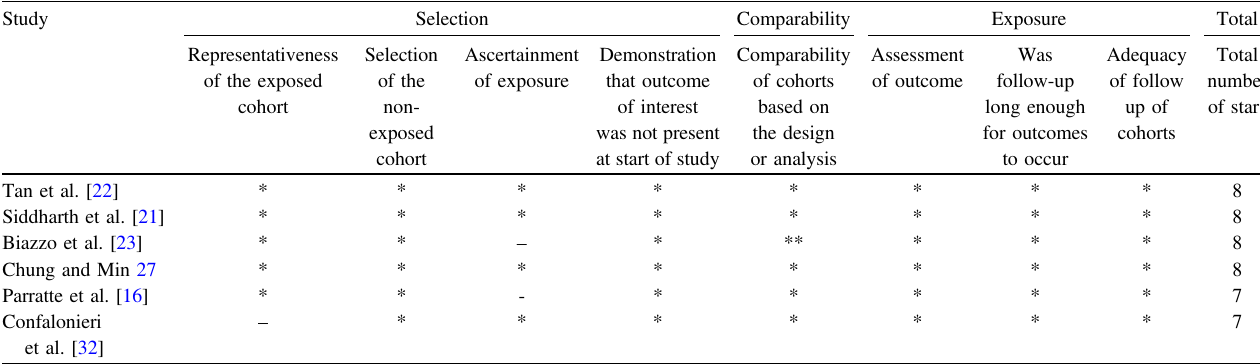
Table 1. Newcastle-Ottawa Scale (NOS) for assessing the quality of observational studies.